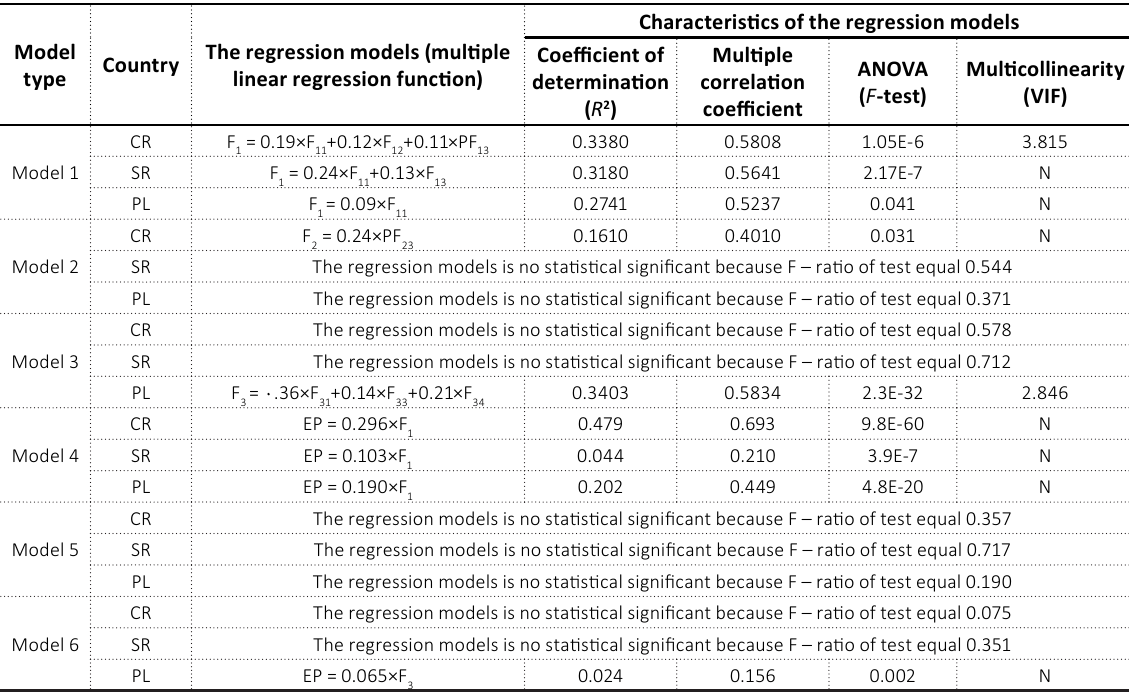
Source: Authors’ results.